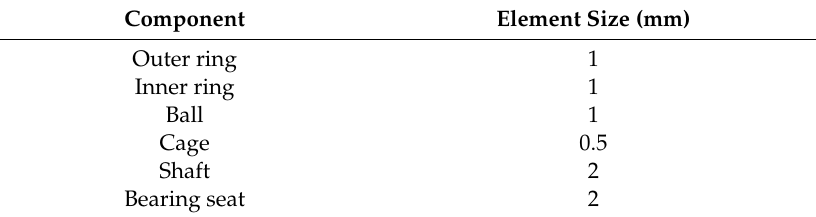
Table 2. The element size of bearing.